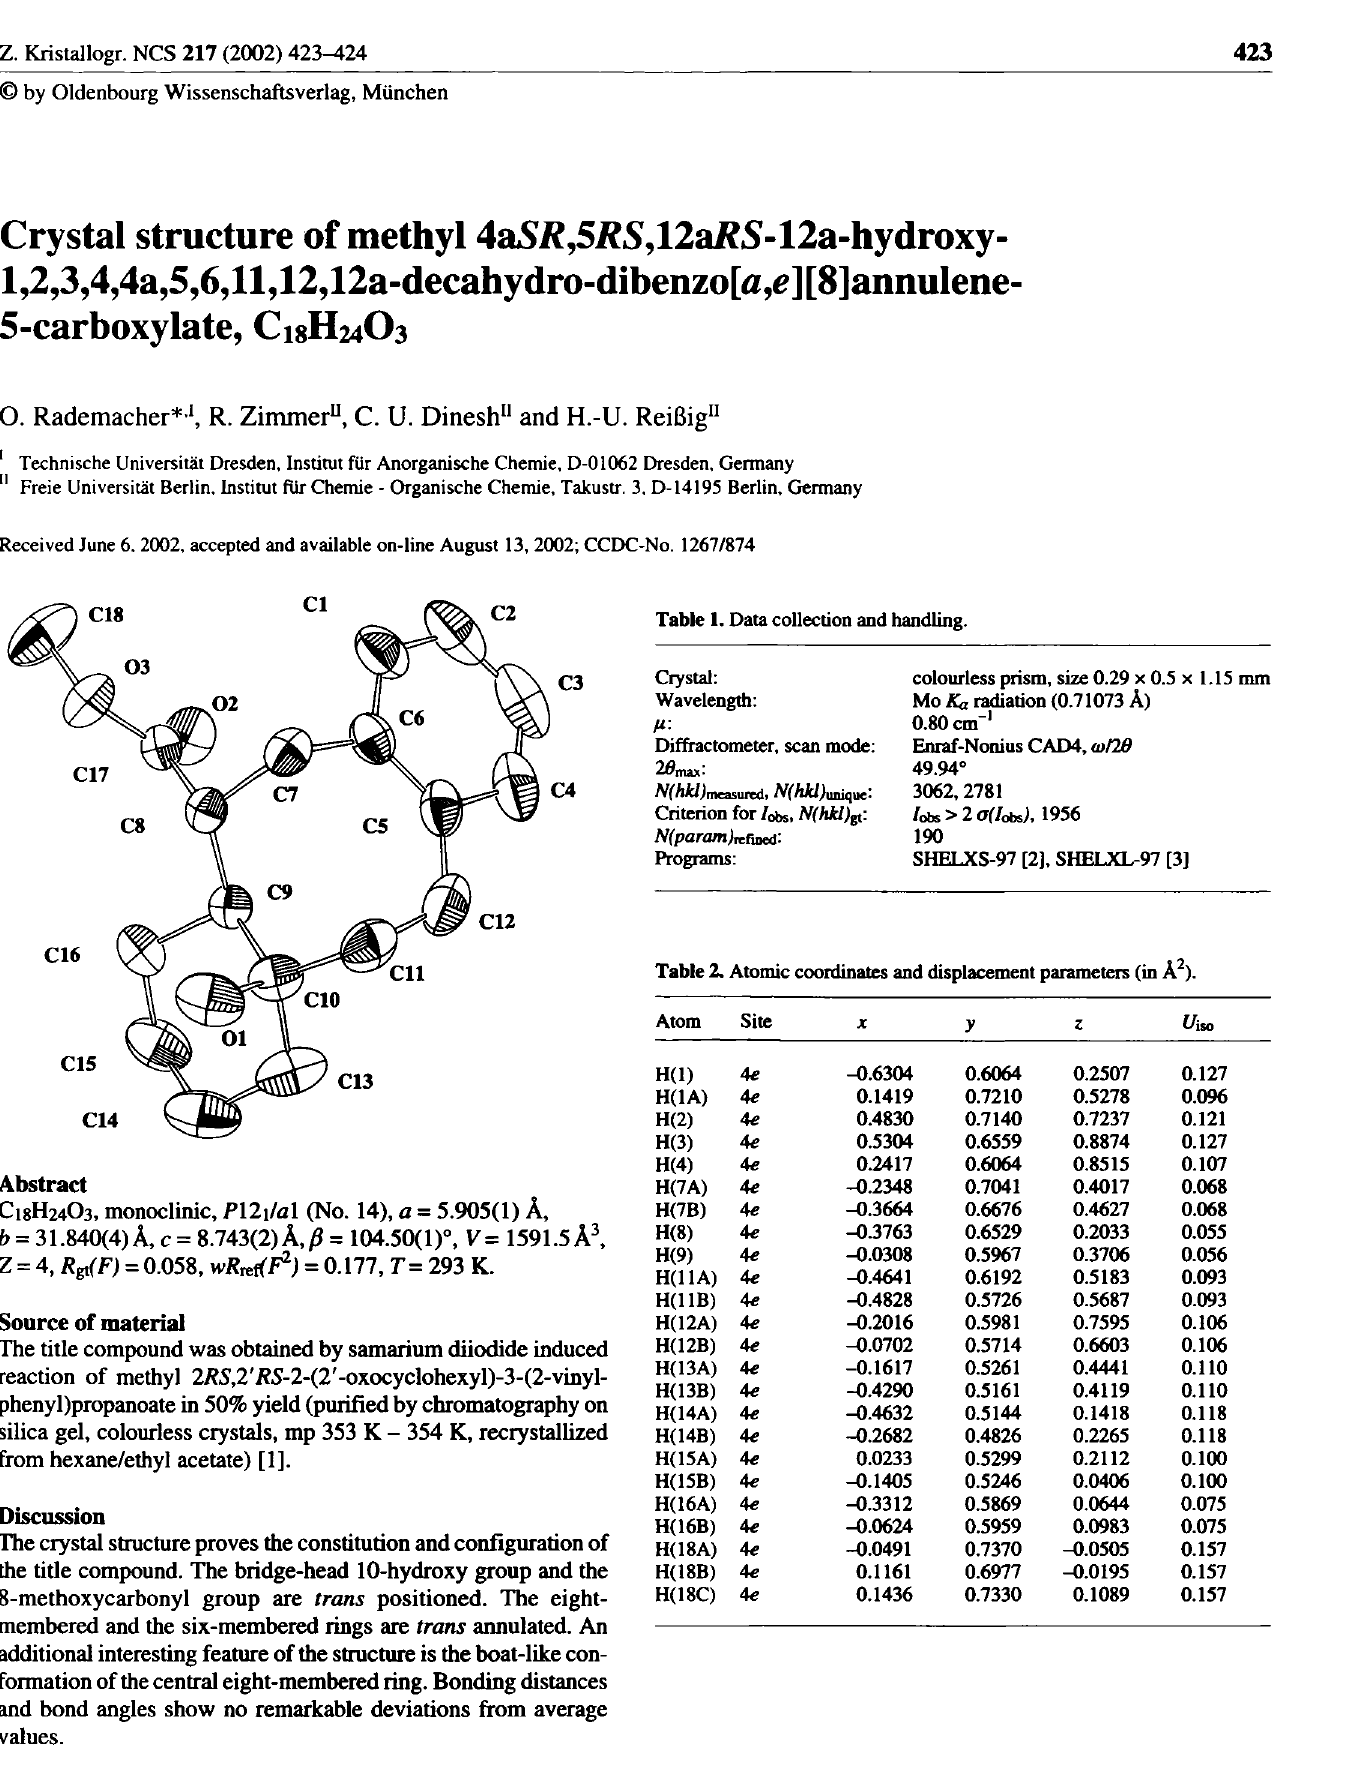
Table 2. Atomic coordinates and displacement parameters (in Â 2